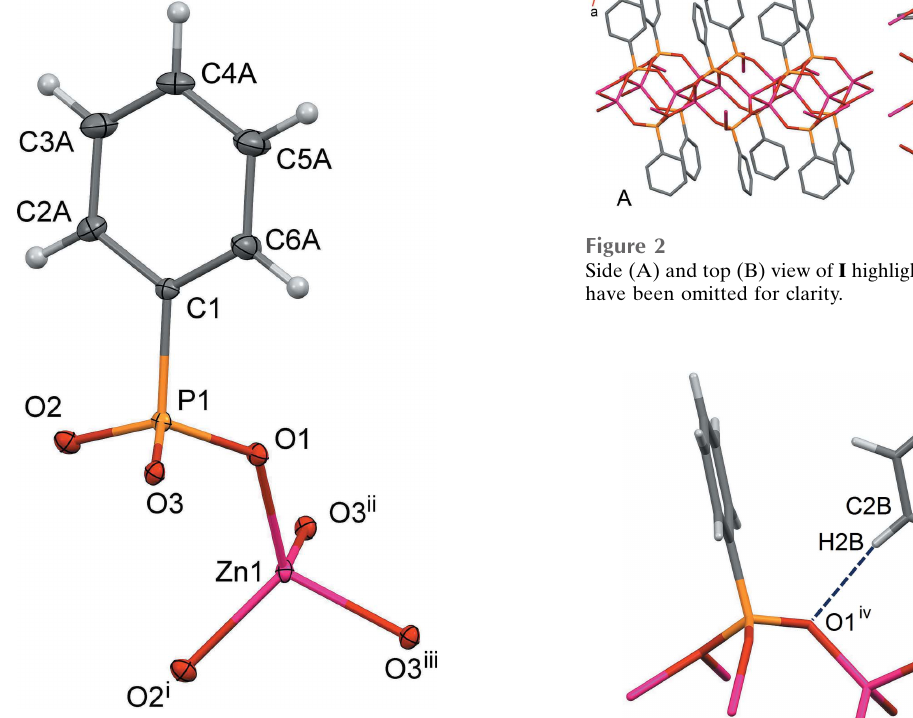
Figure 1 Asymmetric unit of I , plus the oxygen atoms needed to complete the tetrahedral coordination around Zn1. Symmetry codes: (i) (cid:4) x + 1, (cid:4) y + 2, (cid:4) z + 1; (ii) x , (cid:4) y + 3 , z + 1 ; (iii) (cid:4) x + 1, (cid:4) y + 1, (cid:4) z + 1. Only one 2 2 orientation of the disordered phenyl group is shown for